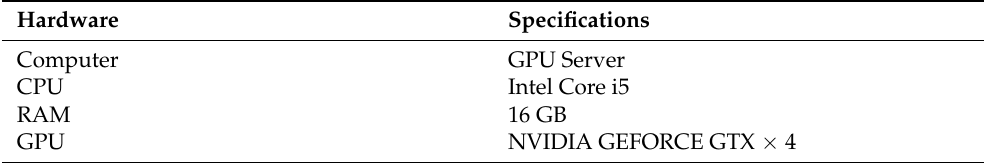
Table 3. System Specifications of the proposed